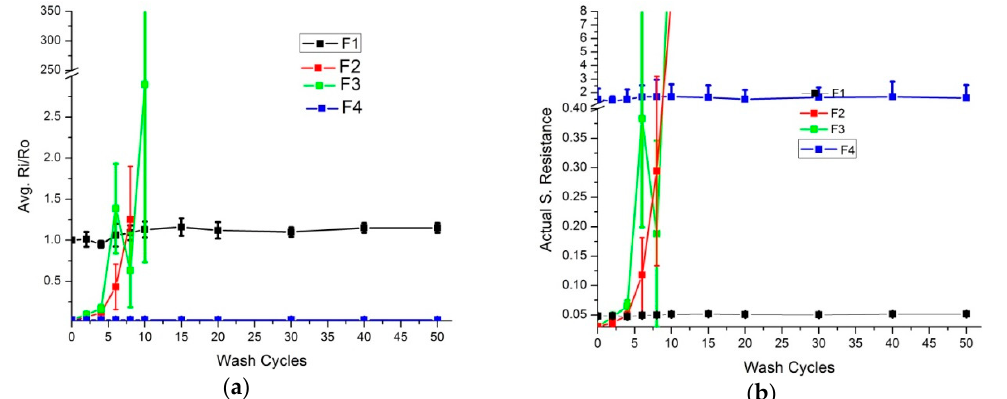
Figure 4. Surface resistance analysis (express wash). ( a ) Comparison of Ri / Ro ( b ) Comparison of actual